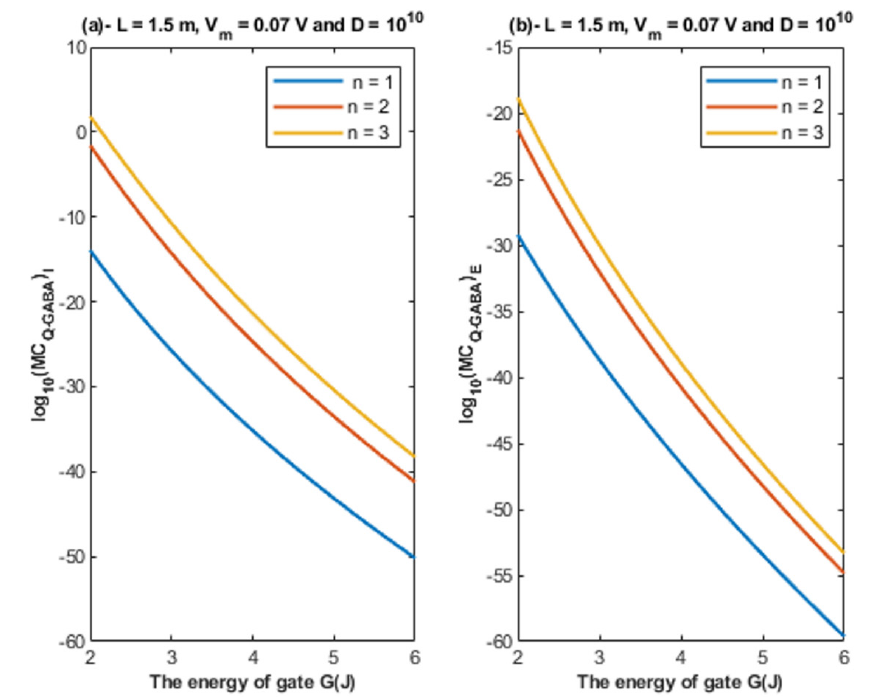
Figure 12. ( a,b ): The figure represents the relationship between the energy of the gate G and the common logarithm of the quantum membrane conductance of the intracellular chloride ions log ( ) MC Q − GABA 10 − and the quantum membrane conductance of the extracellular chloride ions log ( ) MC Q − GABA 10 E − , respectively. The relationships are investigated at different values of gate location and according to the setting values above each graph. Based on Equations (26) and (27), the relationship between the energy of the gate and the quantum membrane conductance is represented at different values of receptors density. See Figure 13.